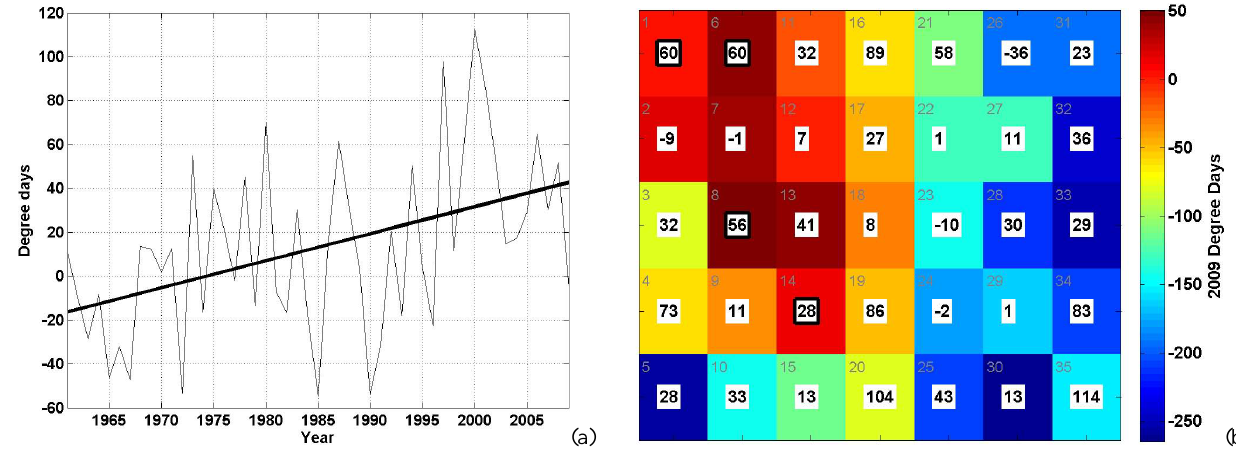
Fig. 7. (a) Degree-days (thin line) 1961–2009 for SOM pattern 6 with trend line (thick line). Here, pattern 6 can be seen getting warmer over time. Here we use the linear trend line only to smooth the noise by using its end-points in (b) and we are not indicating the actual trend is linear. Later in the paper, we explore the change in means of the first 15 and last 15yr of record (e.g., Fig. 9). (b) Change in degree-days 1961–2009 for all SOM patterns at Lake El’gygytgyn. The numbers are the change in trend-line endpoints, as in (a) , and the colors are the degreedays for each pattern in 2009, so that one can estimate the value in 1961 using the numbers. Positive values indicate warming. Here heavy boxes surround those patterns, like pattern 6 from (a) , that change from negative to positive degree-days over time.